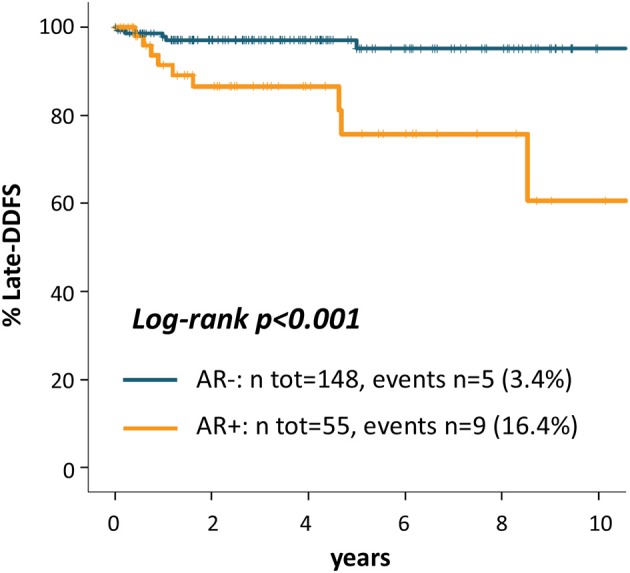
Kaplan Meier curves for late-distant disease-free survival from the landmark of 3 years after diagnosis according to AR.